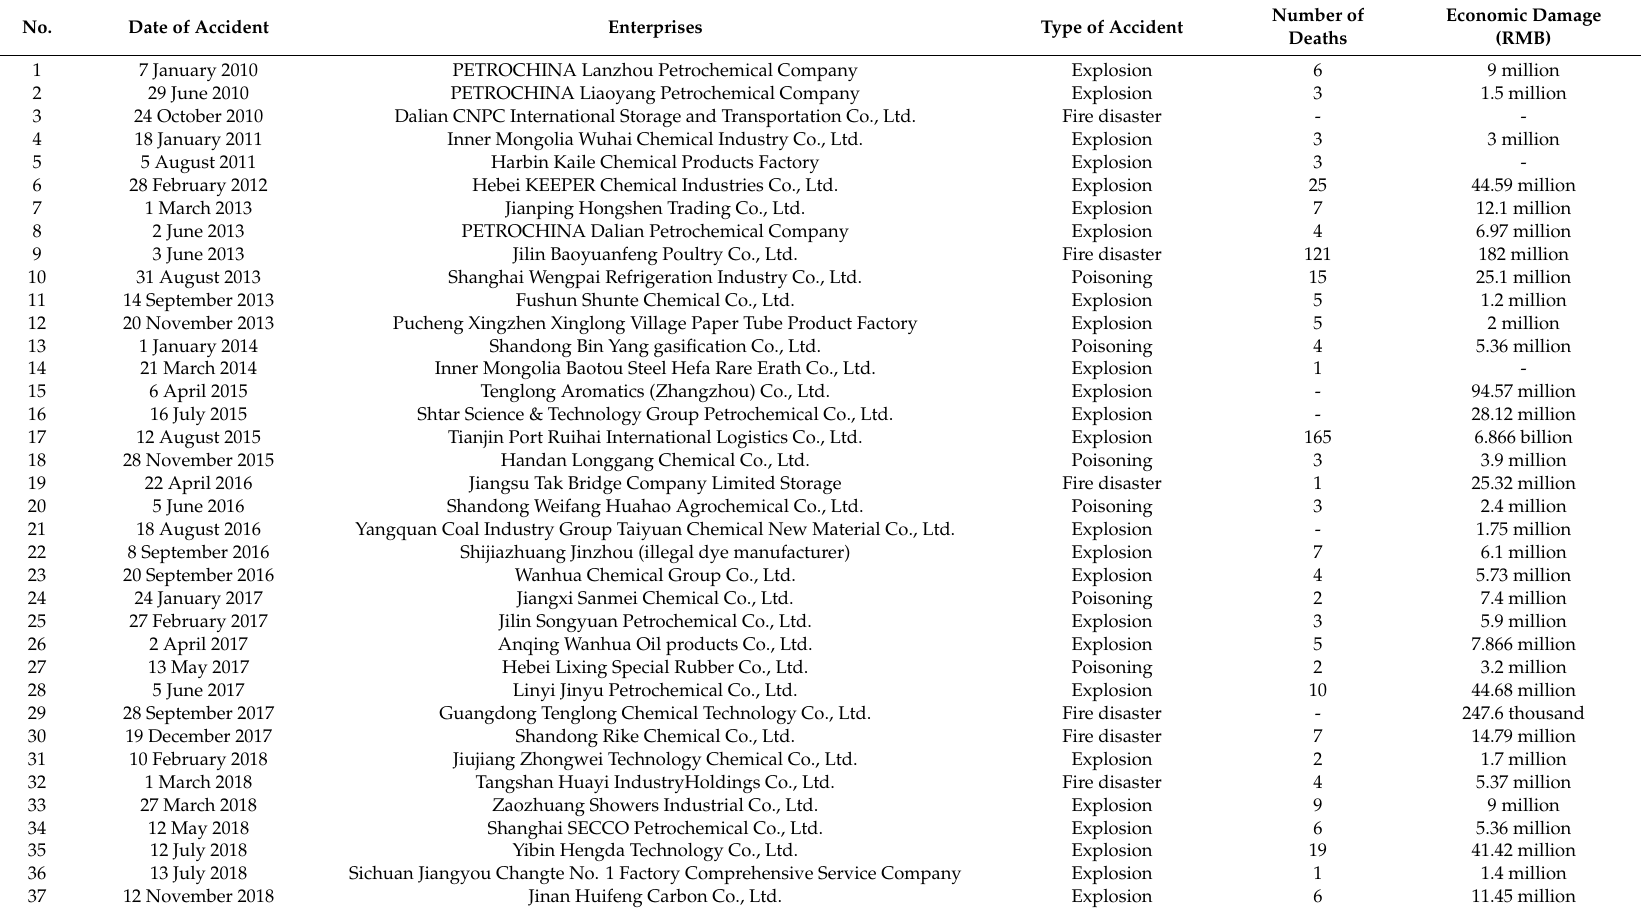
Table 3. Details of 42 hazardous chemical storage